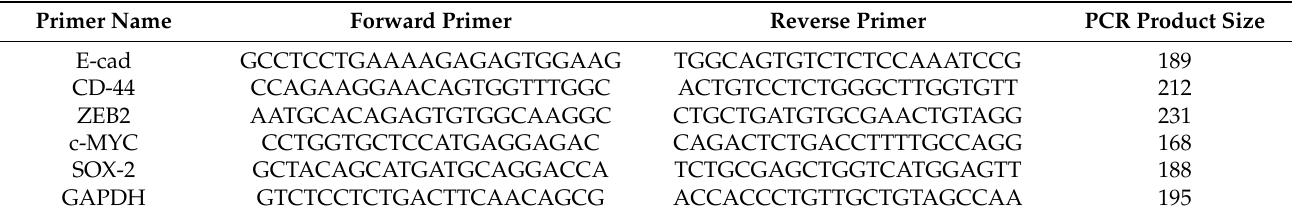
Table 2. List of used primers and their